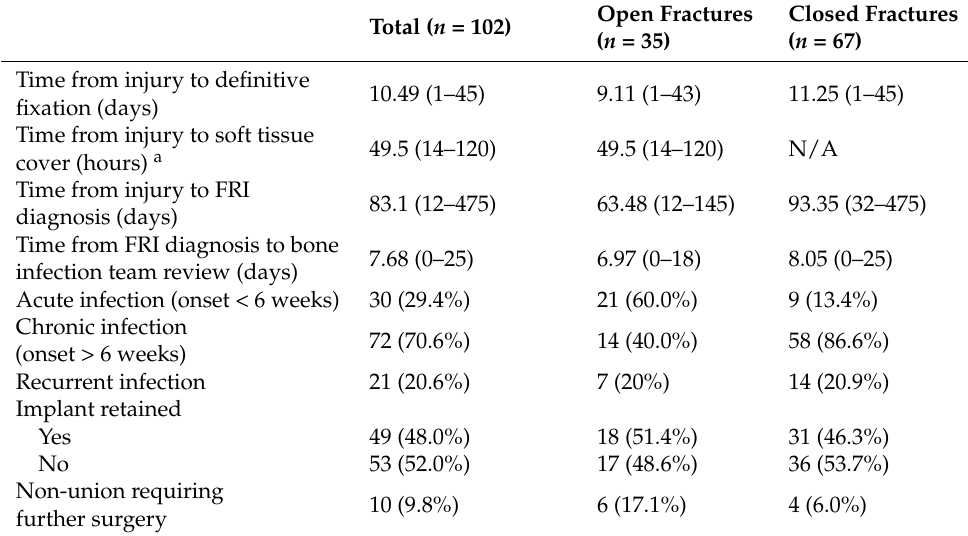
Table 5. Injury and FRI